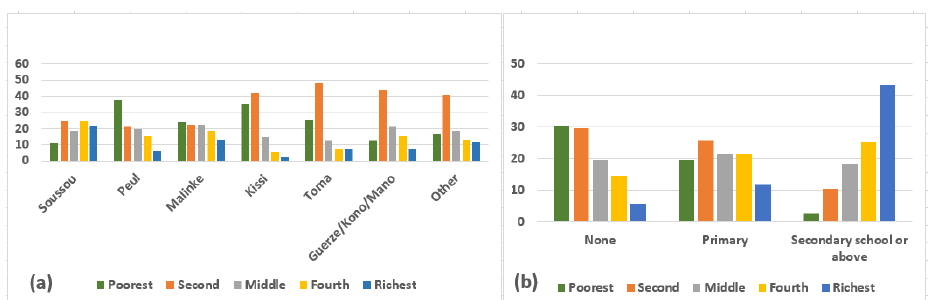
Figure A3. ( a ) Percentage (%) of the positive children of anemia by ethnicity of household head according to the standard of living of household. ( b ) Percentage (%) of the positive children of anemia by education level of mother according to the standard of living of